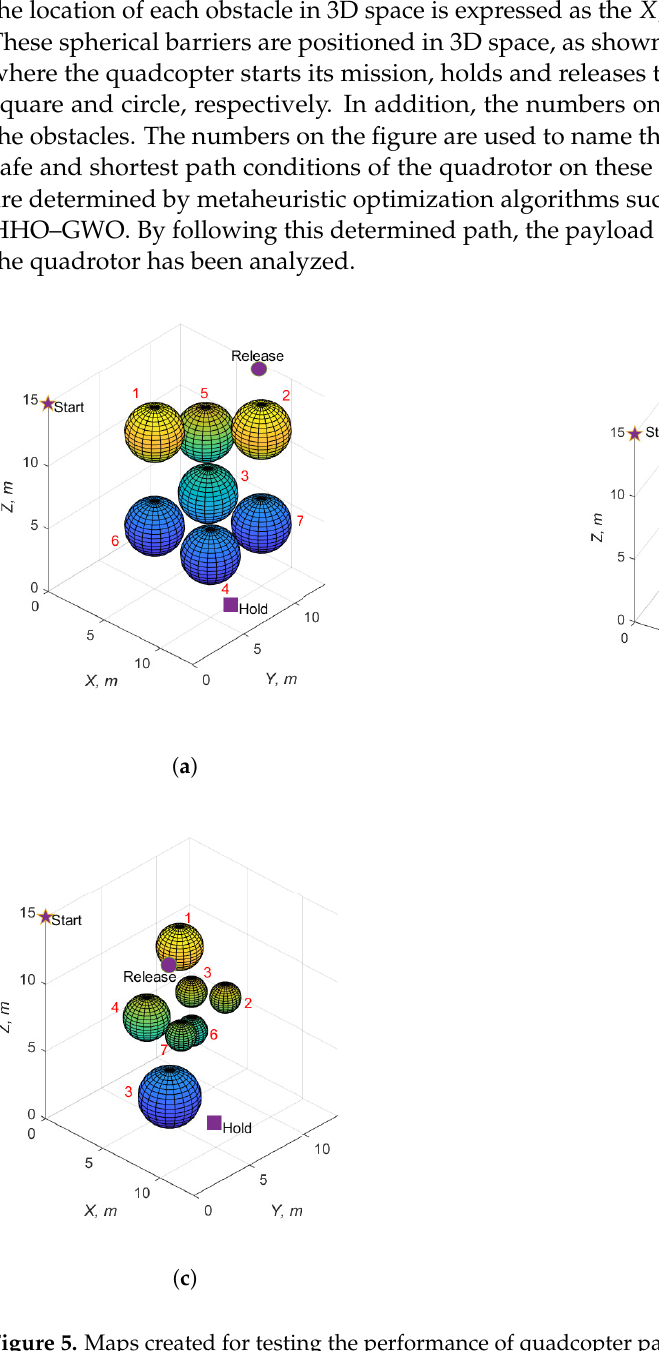
Figure 5. Maps created for testing the performance of quadcopter path planning and tracking ( a ) for Scenario 1, ( b ) for Scenario 2, ( c ) for Scenario